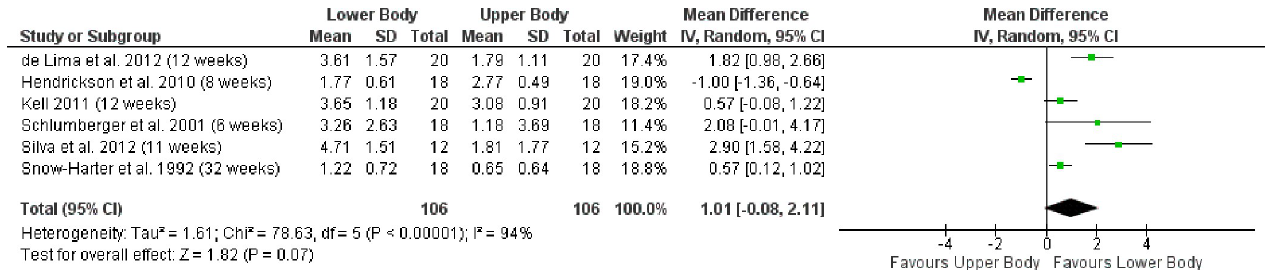
Fig 2. Forrest plot. Lower-body gains compared to upper-body 1RM gains in intermediate and advanced subjects.